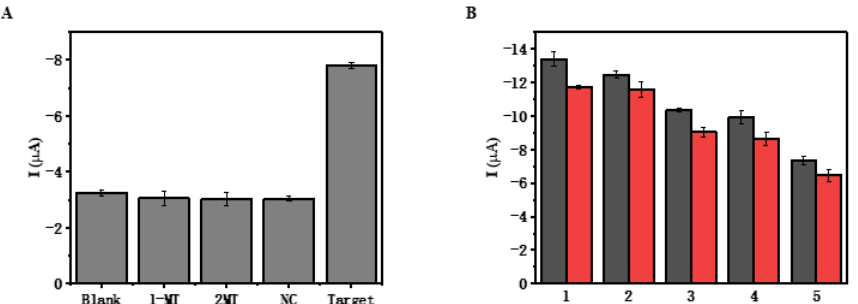
Figure 5. ( A ) Selectivity study of the biosensor for the CYP2C19*2 gene and the interferences. ( B ) DPV peak currents of the biosensor for the detection of the CYP2C19*2 gene (before and after one-week comparison). The standard deviation of three parallel measurements is shown by the error